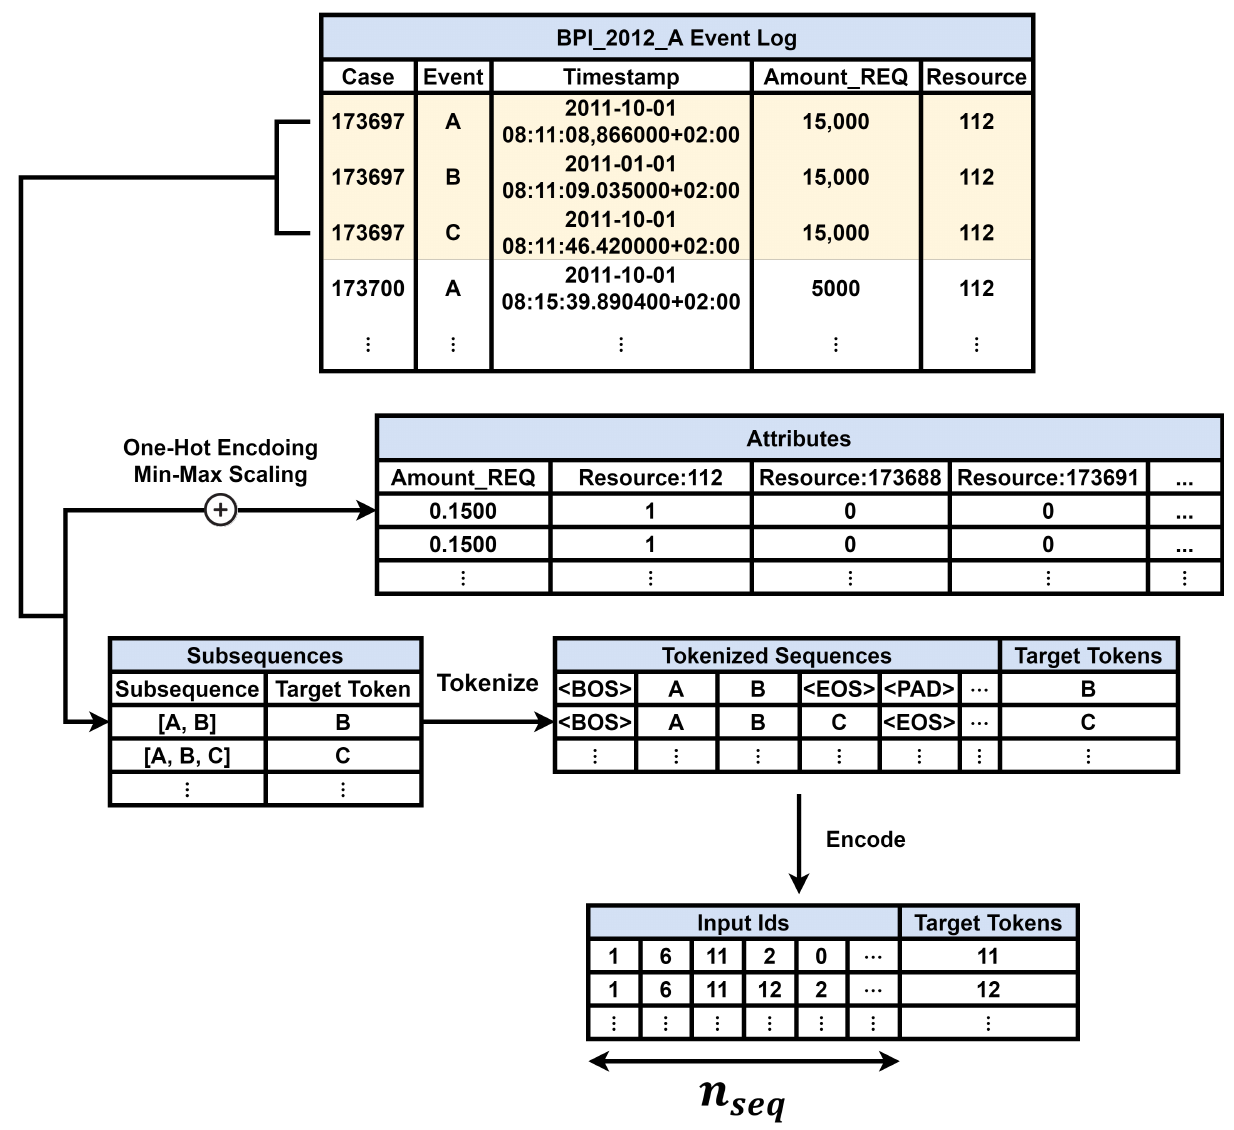
Figure 3. Overall data